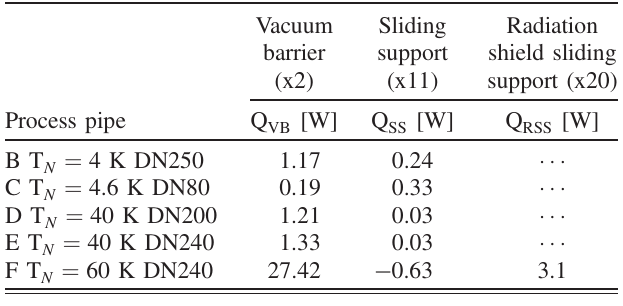
TABLE V. heat flows reaching each of the process pipes through a given type of support.